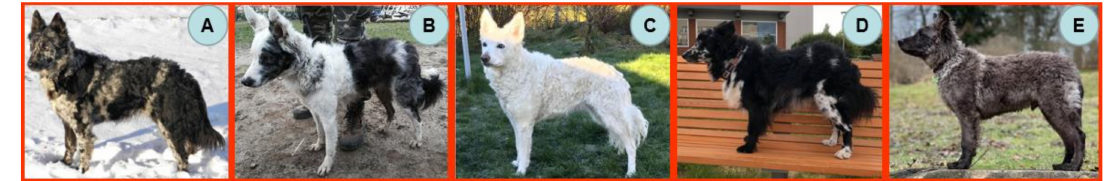
Figure 1. Representative examples for various merle phenotypes of the Mudi breed: ( A ) classic; ( B ) double; ( C ) hidden; ( D ) harlequin; ( E )